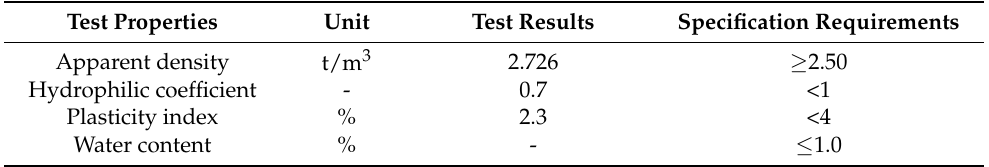
Table 4. Technical indicators of mineral filler.